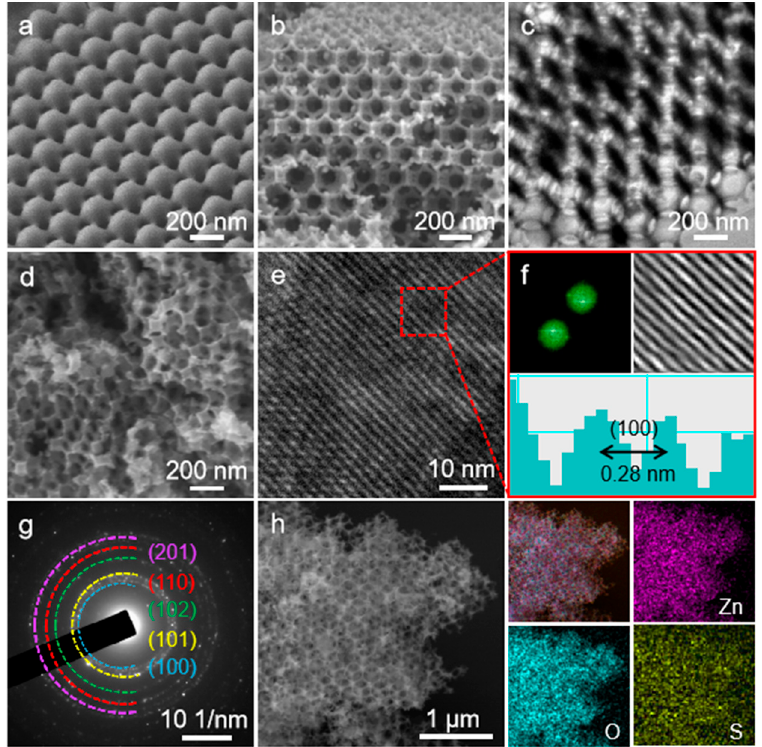
Figure 2. ( a ) SEM image of polymethyl methacrylate (PMMA); ( b ) SEM image and ( c ) TEM image of 3DOM ZnO; ( d ) SEM image of 3D ZnO; ( e ) HRTEM image of 3DOM ZnO; ( f ) FFT pattern and inverse FFT lattice image of 3DOM ZnO; ( g ) SAED patterns of 3DOM ZnO; ( h ) HAADF-STEM image of S / 3DOM ZnO and corresponding Zn, O, and S